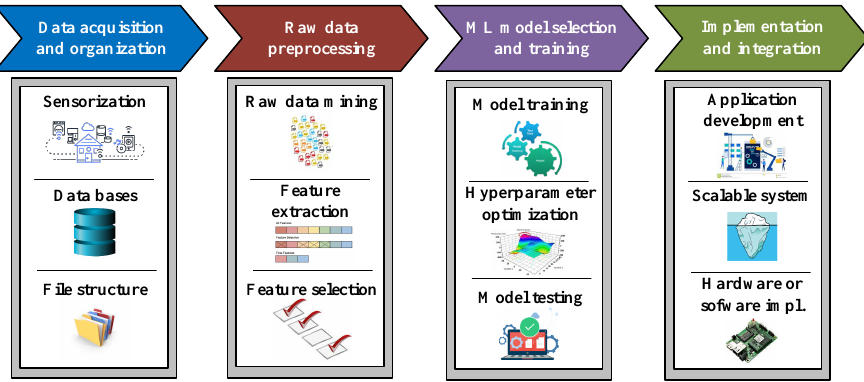
Figure 9. Standardized workflow to apply effectively machine learning approaches.